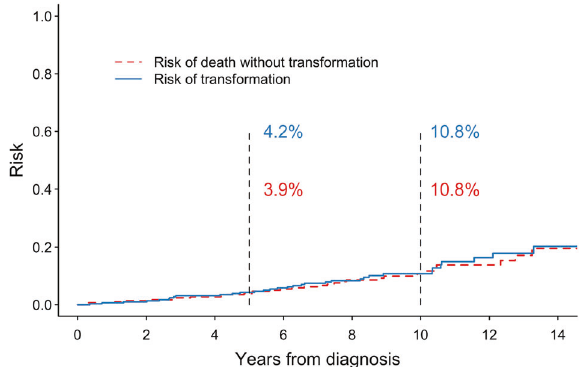
Fig. 5 Competing risk analysis of death and transformation. Competing risk analysis to demonstrate the rate of death without histological transformation and the rate of biopsy-proven histolo- gical transformation after